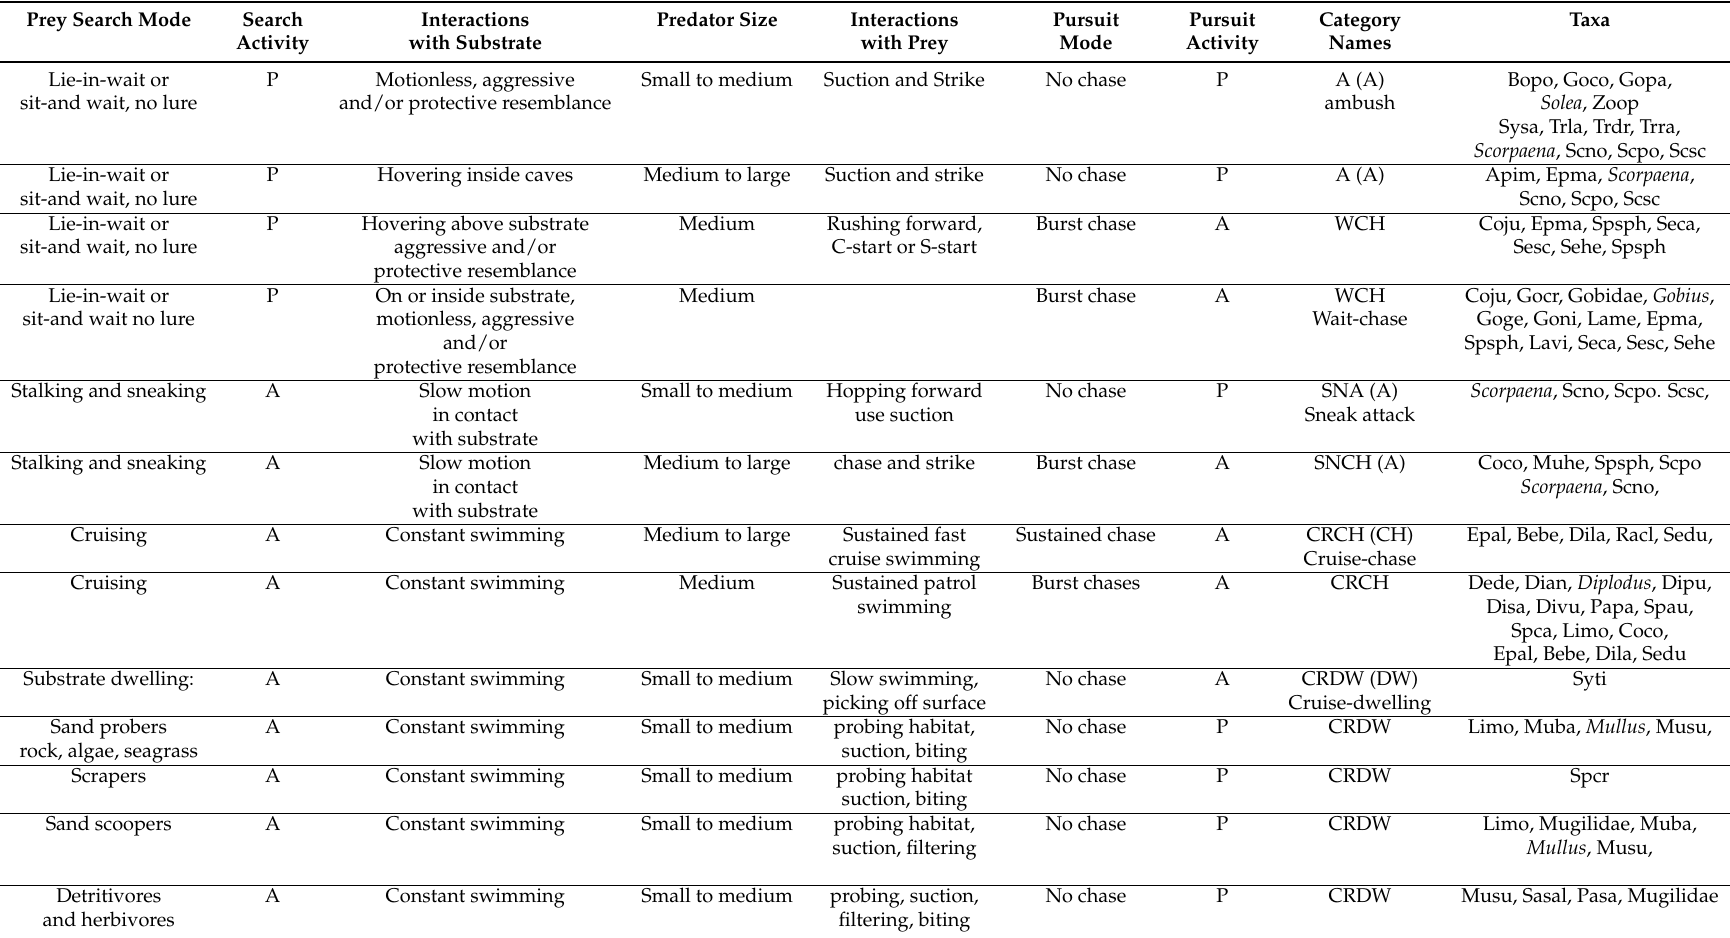
Table 1. Observed predatory fish taxa categorized by predatory behavioral mode. Sources and detailed descriptions: [12,46] and personal observations. Category names in parentheses from